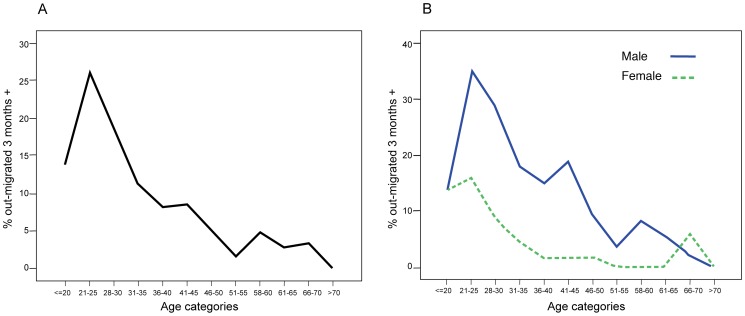
Percentage rise in adults ever-migrated out by age categories n = 3698 (all household members >15 years).Section A includes all adults, and Section B, by sex.